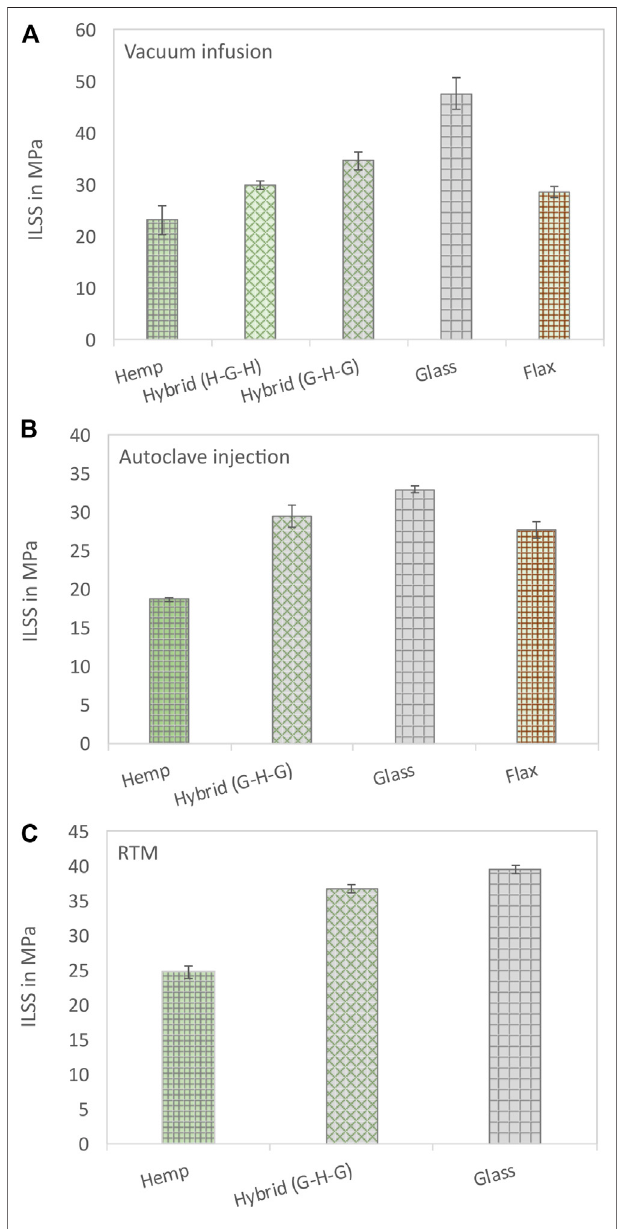
FIGURE 8 | Interlaminar shear strength — ILSS (mean value ± standard deviation)ofcompositelaminatesproducedbyvacuuminfusion (A) ,autoclave injection (B) and RTM (C)